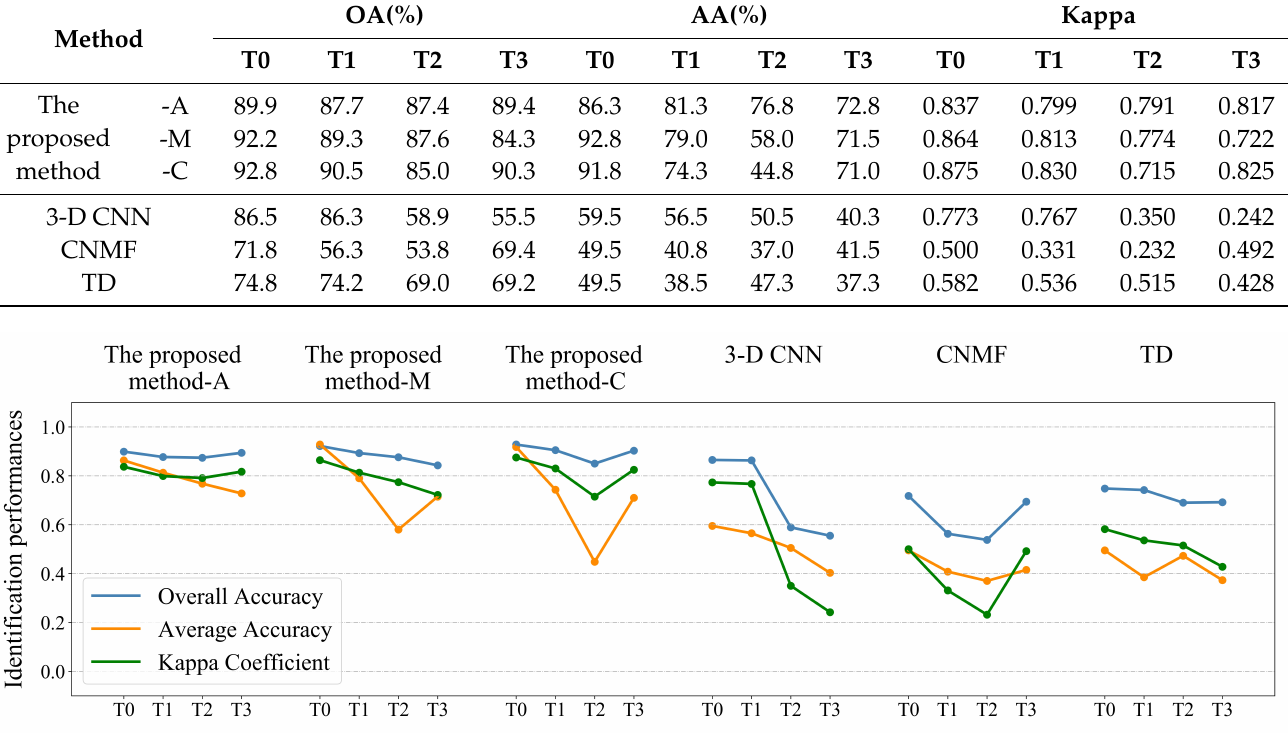
Figure 19. Identification performance chart of the measured data (OA-AA-Kappa).